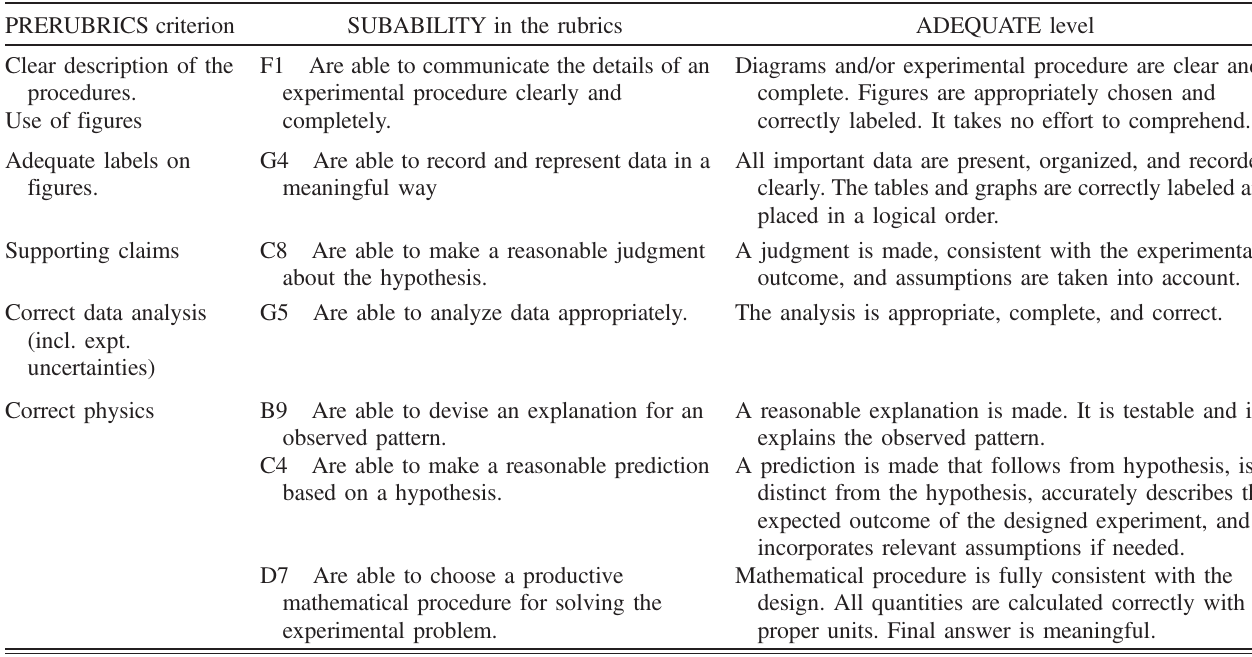
TABLE III. A comparison between the subabilities in the prerubrics period (first column) and the subabilities in the rubrics period. Note that all criteria can be mapped to statements in the adequate column of the new